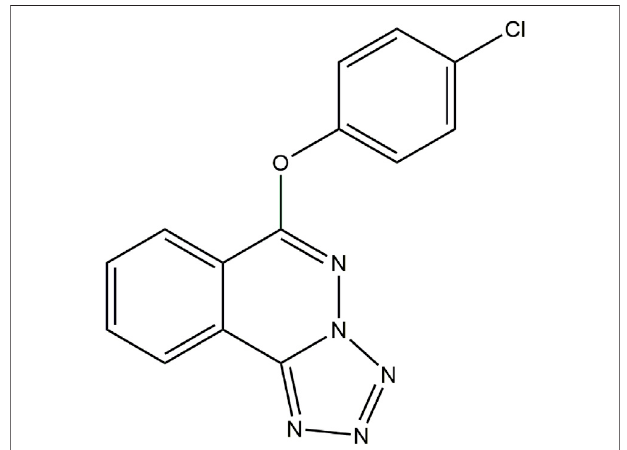
FIGURE 1 | Chemical structure of